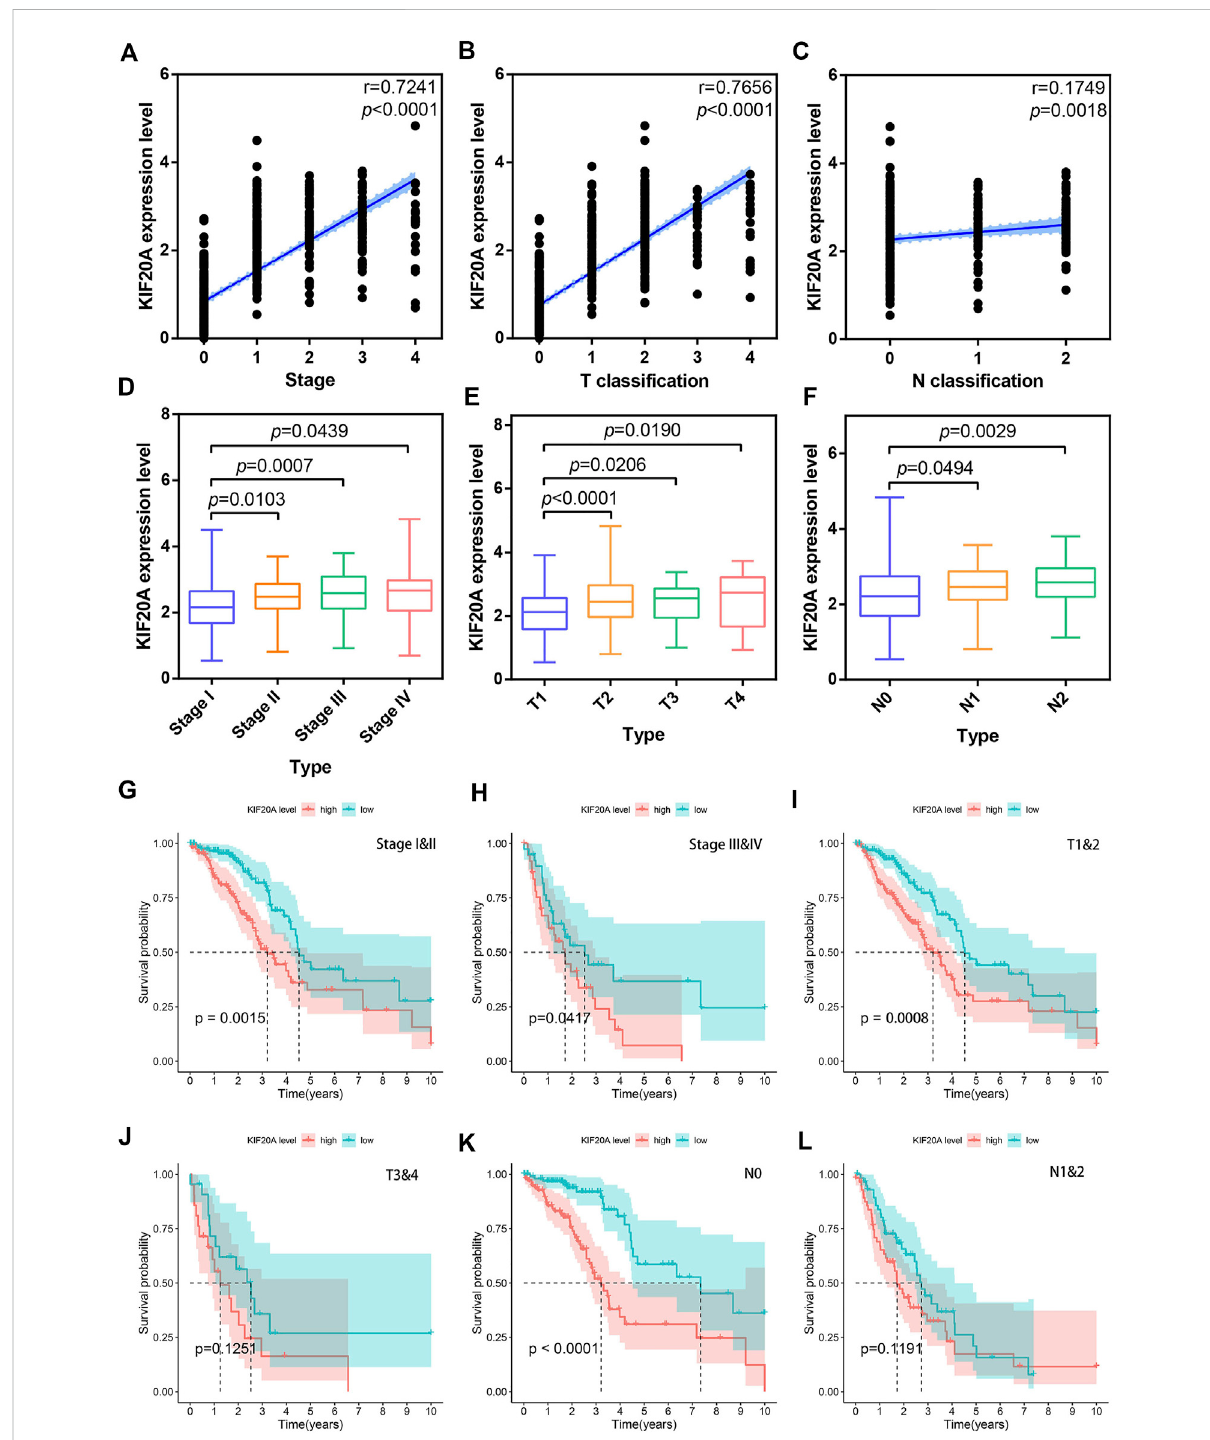
FIGURE 7 Correlation of KIF20A expression with clinical characteristics according to the TCGA dataset. Scatter plots show the correlation of KIF20A expression with tumor stage (A) , T classi fi cation (B) , and N classi fi cation (C) . Boxplots show the differential analysis of KIF20A expression in different tumor stages (D) , T classi fi cation (E) , and N classi fi cation (F) . Kaplan-Meier survival analysis shows the correlation of KIF20A expression with OS in LUAD patients according to tumor stage: stage I&II (G) and stage III and IV (H) , primary tumor: T1 and 2 (I) and T3 and 4 (J) , and lymph node metastasis: N0 (K) and N1&2 (L)